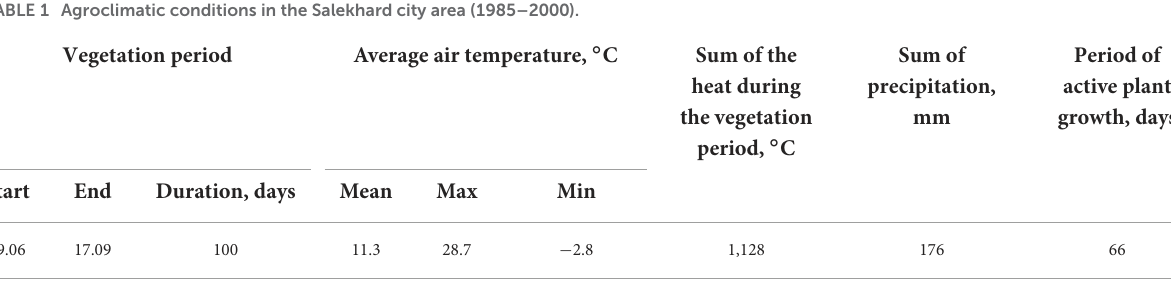
TABLE 1 Agroclimatic conditions in the Salekhard city area (1985–2000). Vegetation